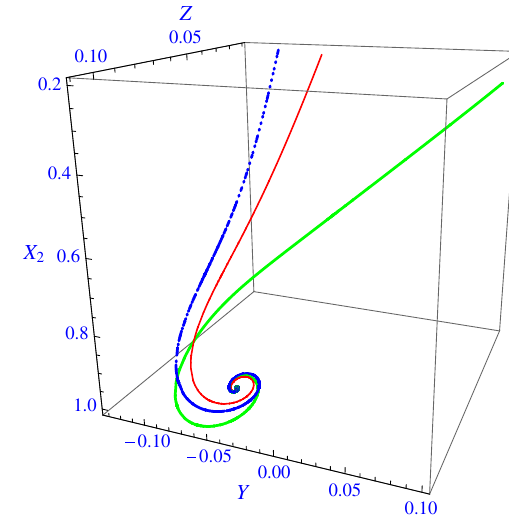
0 ), X 2 ( t = 0 ), Y ( t = 0 ), Z ( t = 0 )) aresetas ( 0 . 1 , 0 . 2 , − 0 . 05 , 0 . 02 ) for the thin solid red curve, ( 0 . 1 , 0 . 25 , 0 . 1 , 0 . 025 ) for the thick solid green curve, and ( 0 . 15 , 0 . 2 , − 0 . 1 , 0 . 01) for the blue dotted curve,